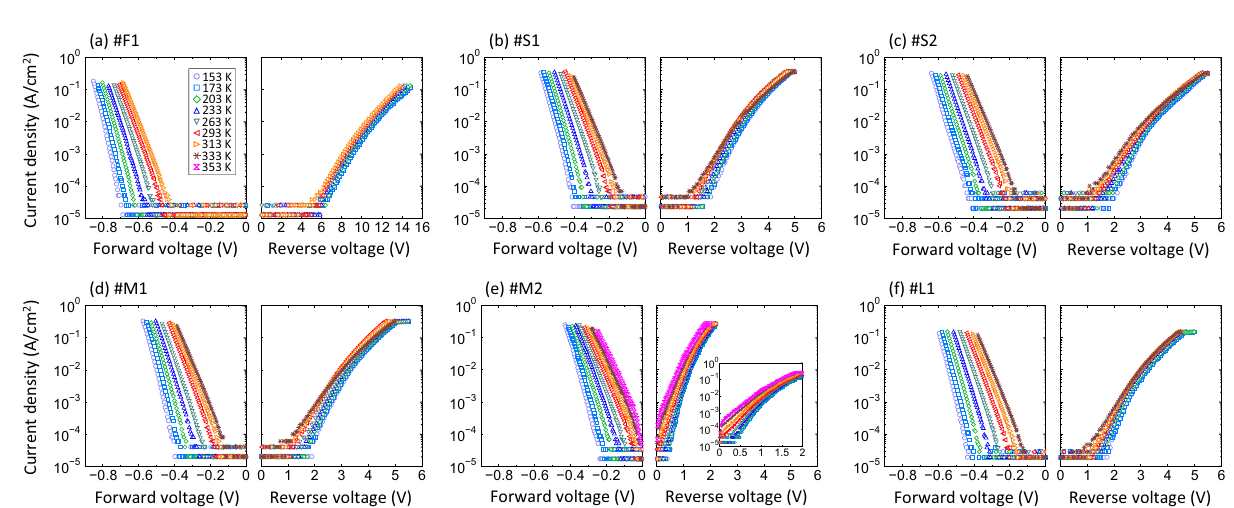
Figure 4. J-V-T characteristics of the ( a ) #F1, ( b ) #S1, ( c ) #S2, ( d ) #M1, ( e ) #M2 and ( f ) #L1